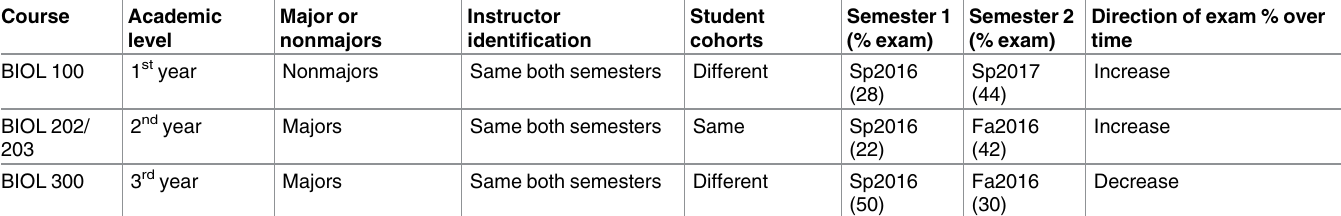
Table 2. We compared three courses that changed grading schemes over the course of two